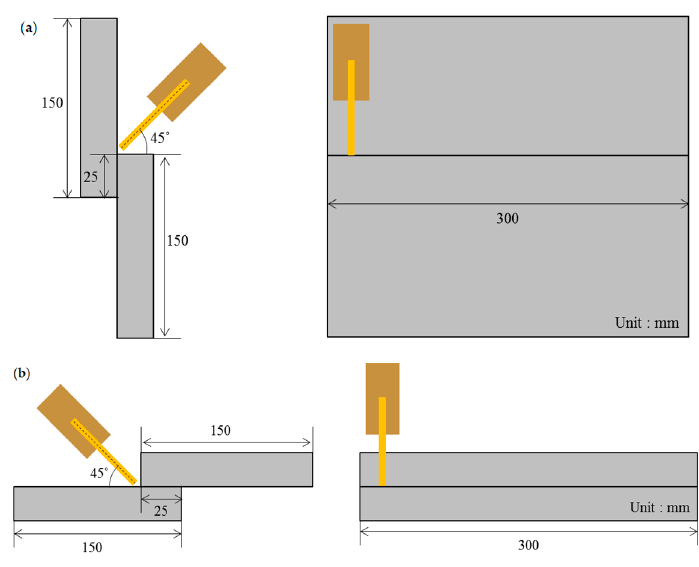
Figure 1. Weld joint geometry: ( a ) Geometry A; ( b ) geometry B.